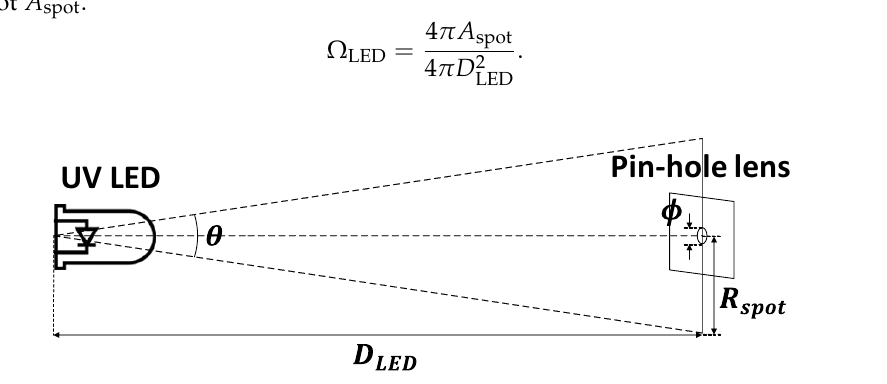
Figure 11. Geometry of UV LED and detector in the ground simulation